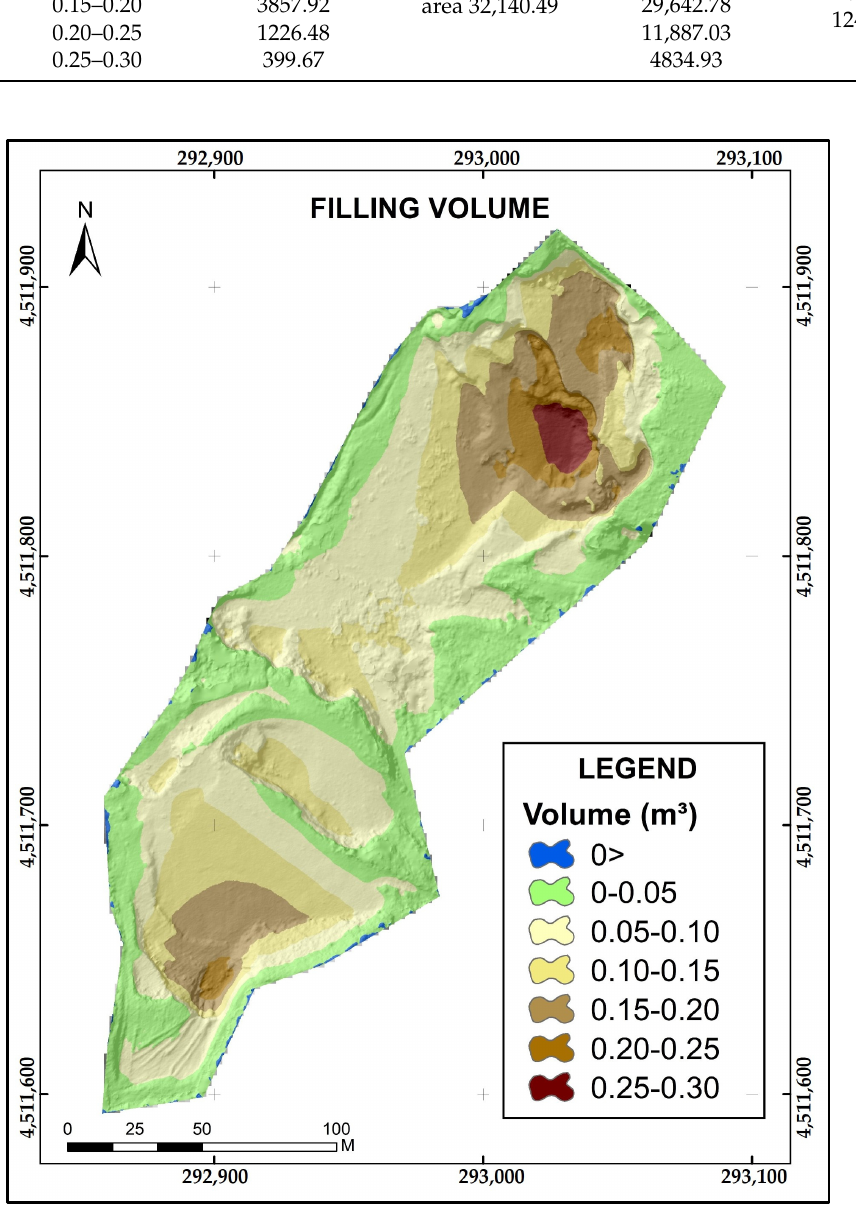
Figure 6. Spatial distribution of the volume required to restore the Belén gravel pit.